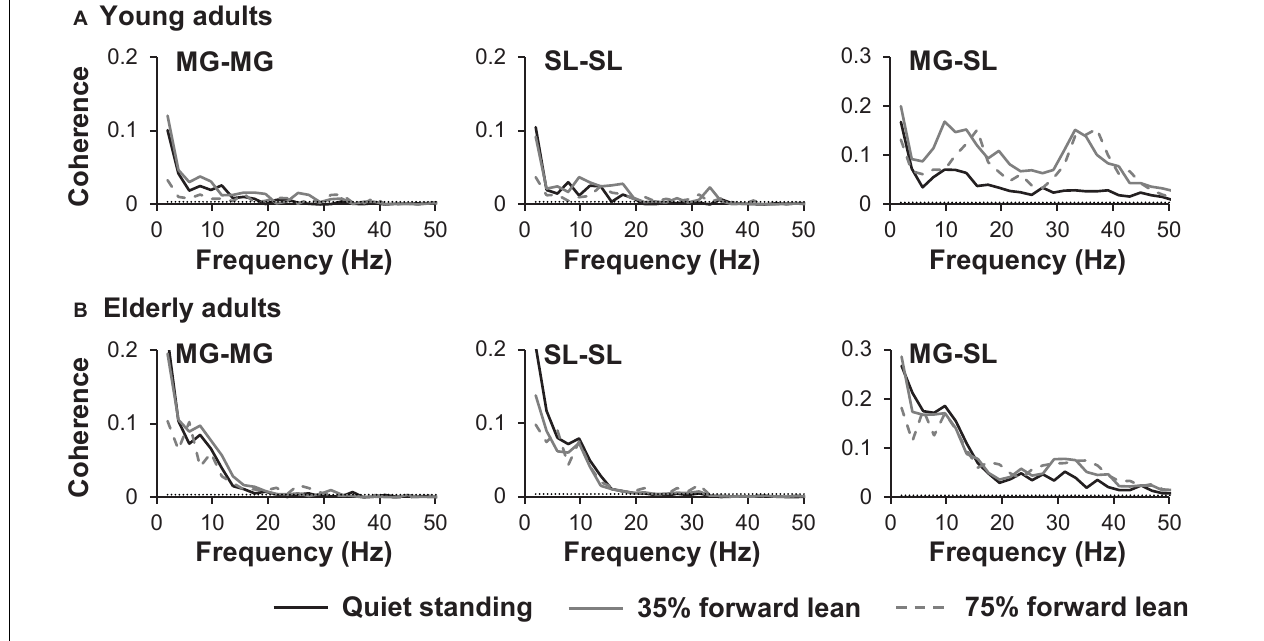
FIGURE 4 | Pooled coherence spectra for young (A) and elderly (B) adults. Data are presented separately for each task and muscle pair. Horizontal dashed line indicates the 95% confidence limit. MG, medial gastrocnemius; and SL, soleus.